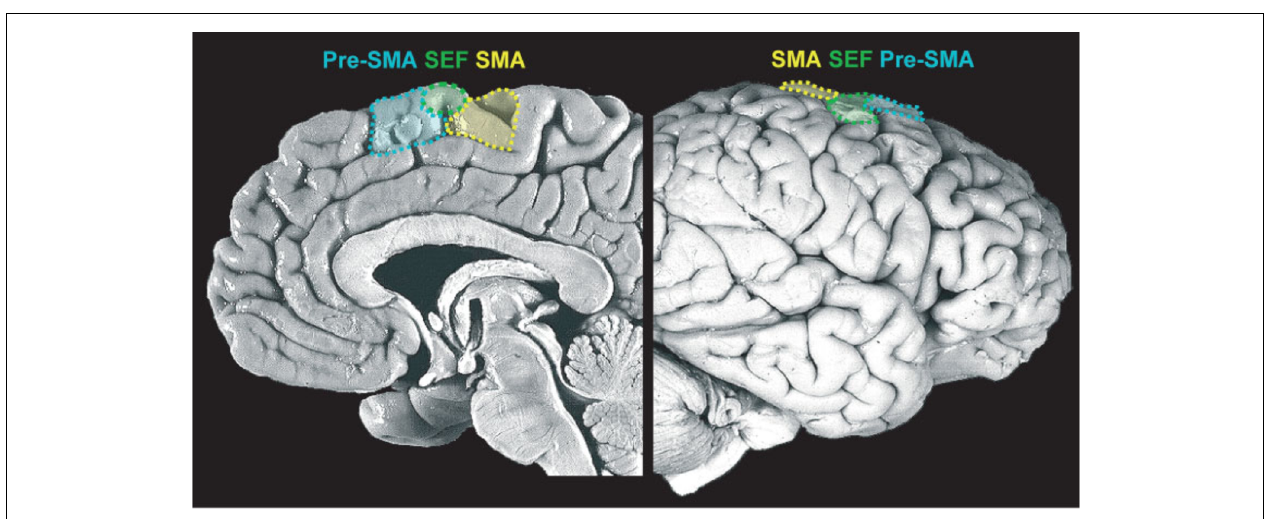
FIGURE 2 | Medial frontal cortex (details of the medial portion of Brodmann areas 6 and 8). Midsagittal view of the medial wall (left) and lateral prefrontal cortex (LPFC) surface (right) , delineating the supplementary